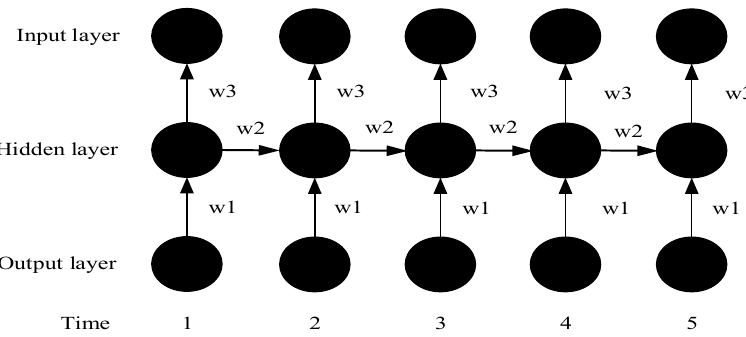
Figure 2. Recurrent Neural Network expansion structure.